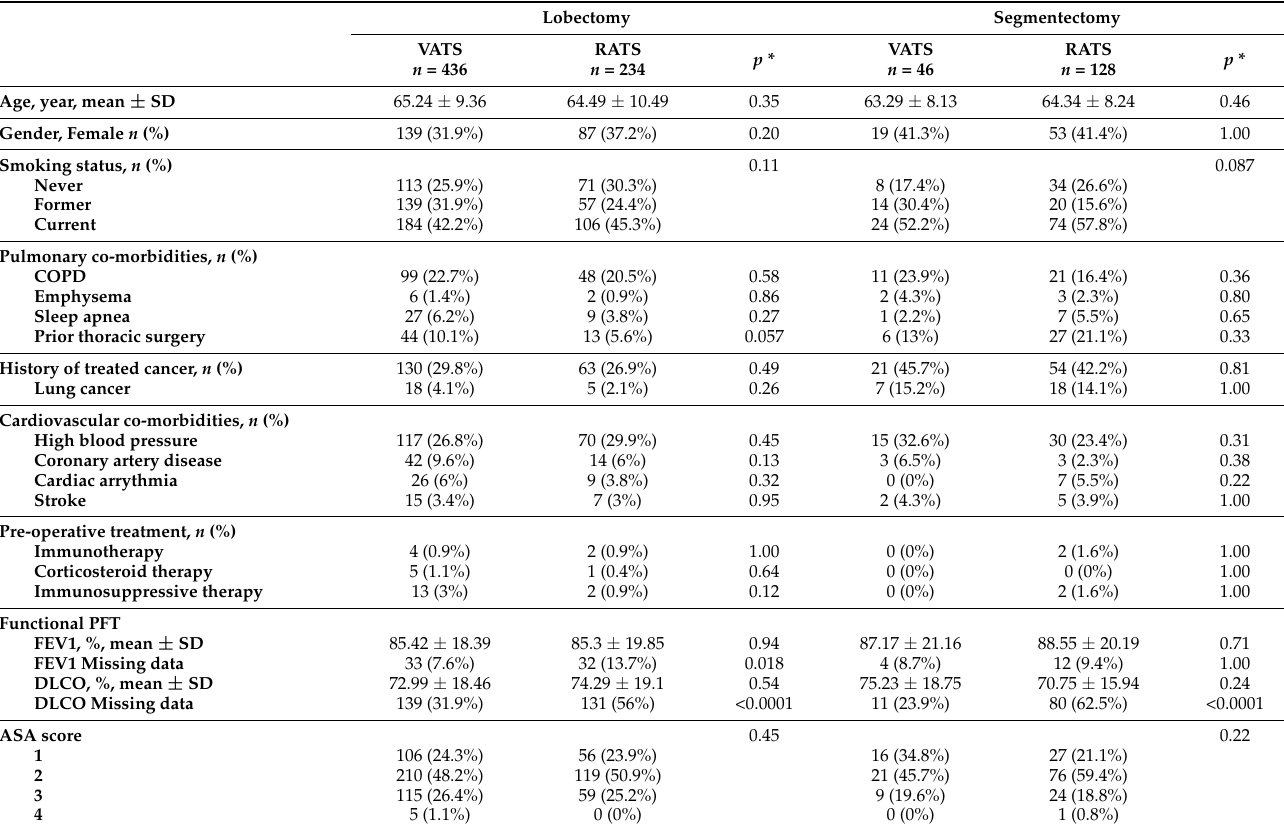
Figure 2. Flow-chart of our surgical series of resectable NSCLC treated by lobectomy and segmentec- tomy performed by VATS and RATS from the 1st January 2012 to 31st December 2019. Table 1. Pre-operative characteristics of patients who had lobectomy and segmentectomy, according to VATS and RATS